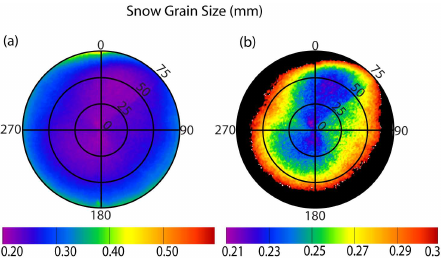
Figure 8 . Scattering functions for Mie (50 μ m) model (dashed line), fractal model (circles), and 20 μ m (solid line), 50 and 200 μ m (dotted lines) spheroid models. Scattering functions for the Fig. 8. Scattering functions for Mie (50µm) model (dashed line), spheroid family are close to each other in the right plot. fractal model (circles), and 20µm (solid line), 50 and 200µm (dot- ted lines) spheroid models. Scattering functions for the spheroid family are close to each other in the right plot.